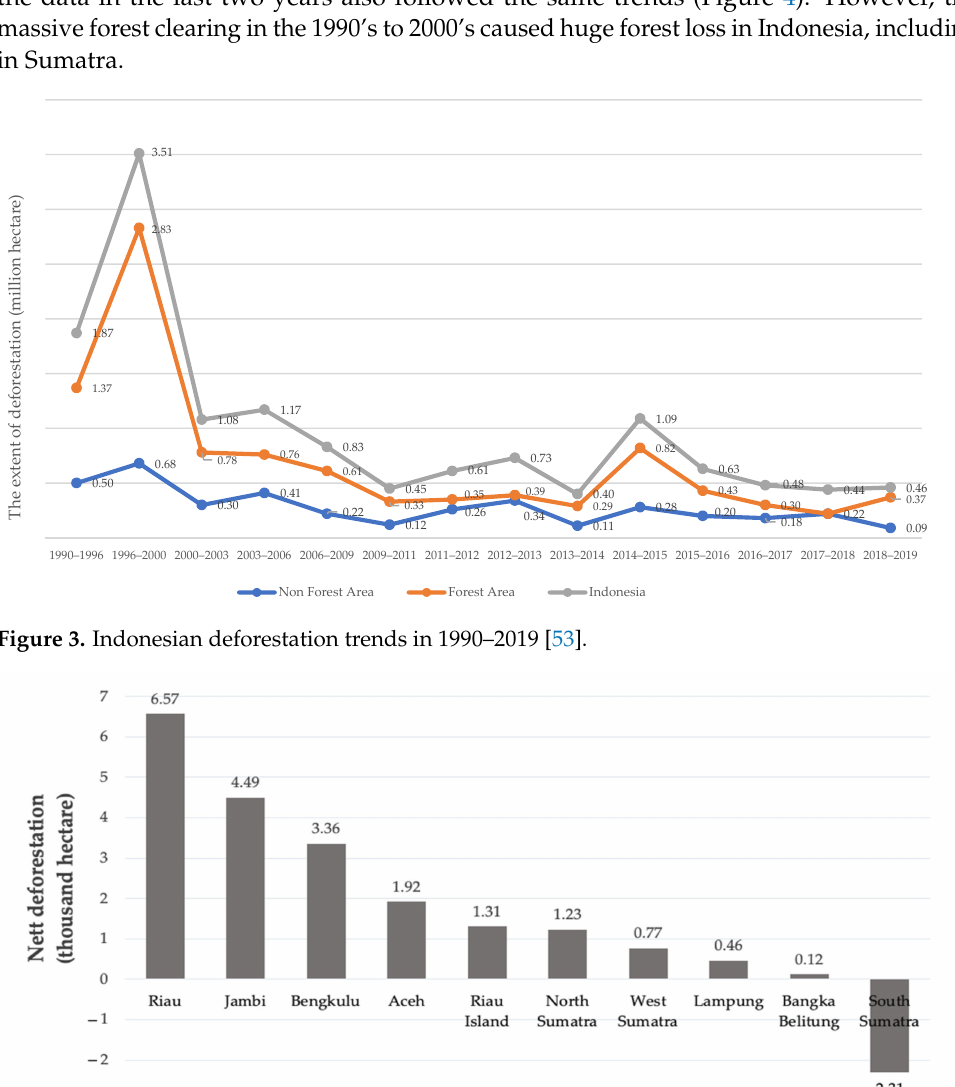
Figure 4. Nett deforestation in Sumatra in 2019–2020 [54]. Nett deforestation is the change/reduction of the land cover area by forested category in a certain period obtained from the calculation of gross deforestation area minus the area of reforestation. Gross deforestation ‘without taking into account the reforestation that occurs’. Minus ( − ) means: that reforestation has a bigger